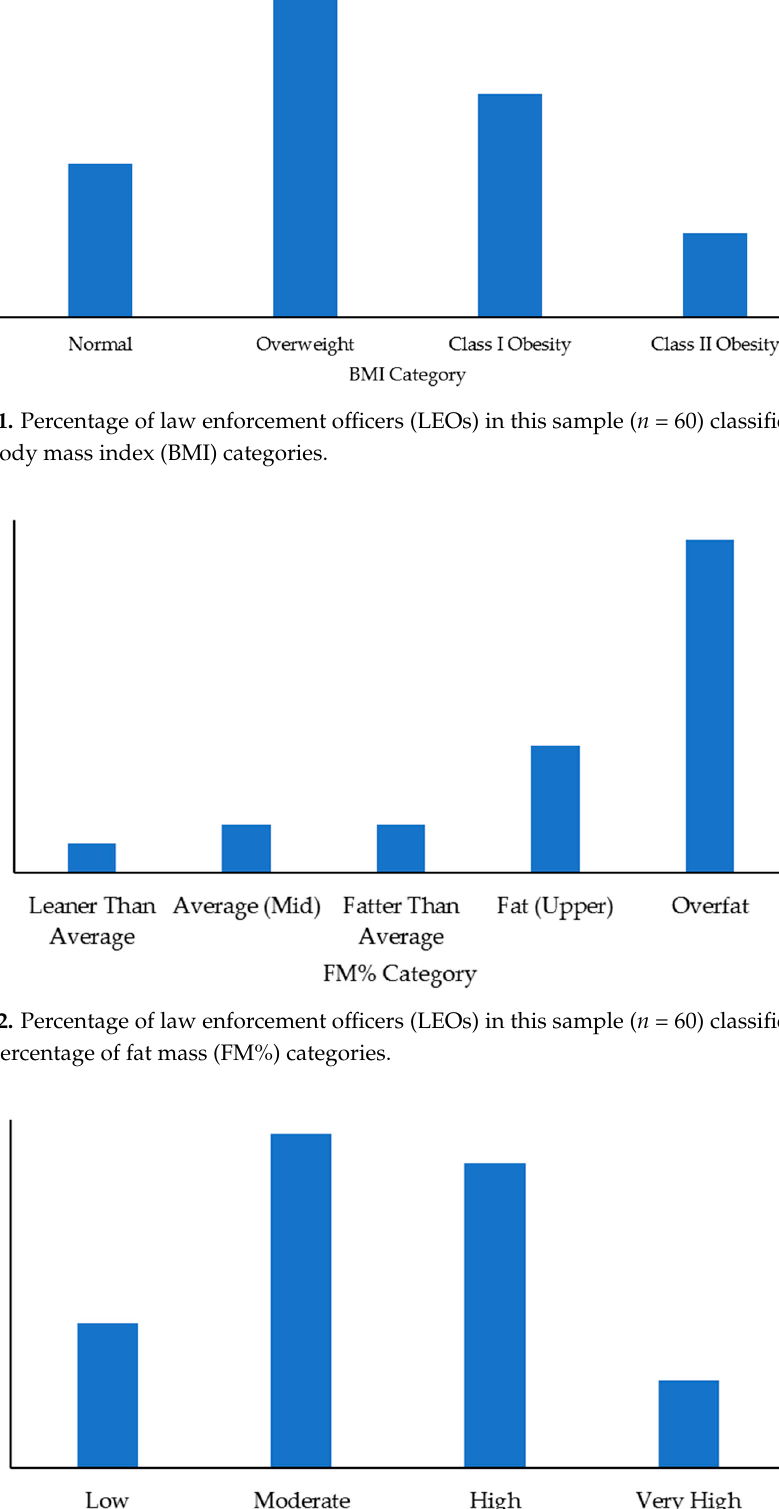
Figure 4. Percentage of law enforcement officers (LEOs) in this sample ( n = 60) classified according to the resting heart rate (RHR) categories. Figure 5. Percentage of law enforcement officers (LEOs) in this sample ( n = 60) classified according to the blood pressure standards.